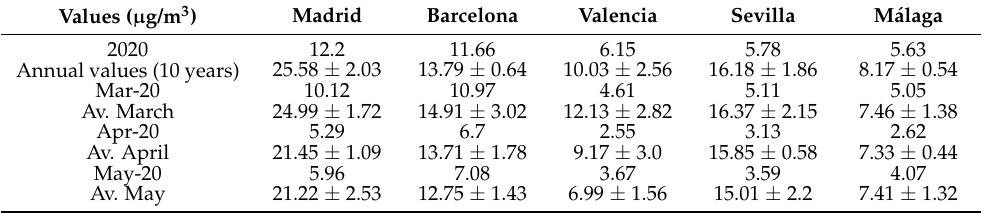
Table 3. Comparison of nitrogen dioxide values in 2020 and the 10 years of data series. Av. = average. Values ( µ g/m 3